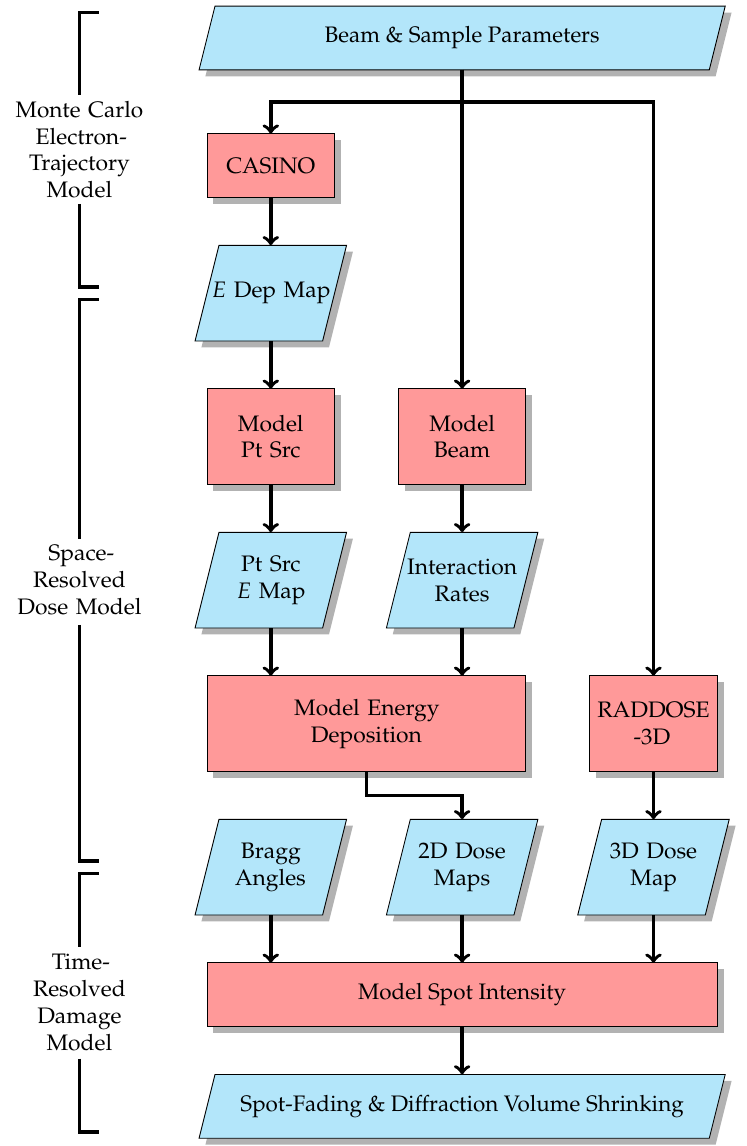
Figure 6. Flow diagram of our simulations, which were performed using a combination of 3rd-party applications, CASINO (red) and RADDOSE-3D [9] (pink), and our own MATLAB scripts (orange). Rectangles represent processes, parallelograms are inputs/outputs. CASINO output ( E Dep Map ) gives (ensemble-averaged) energy-deposition of an electron with a particular initial direction; post-processing of this data in MATLAB produces a dose map for a point source of photoelectrons with emission-direction weighted for a horizontally polarised X-ray beam. MATLAB scripts are further used to determine the dose footprint of the X-ray beam, accounting for spatially-distributed energy deposition by photoelectrons. RADDOSE-3D [9] is used to produce a dose map of the crystal that does not account for photoelectron escape. Our final MATLAB script models the loss in integrated intensity of a 3Å Bragg spot with and without accounting for photoelectron